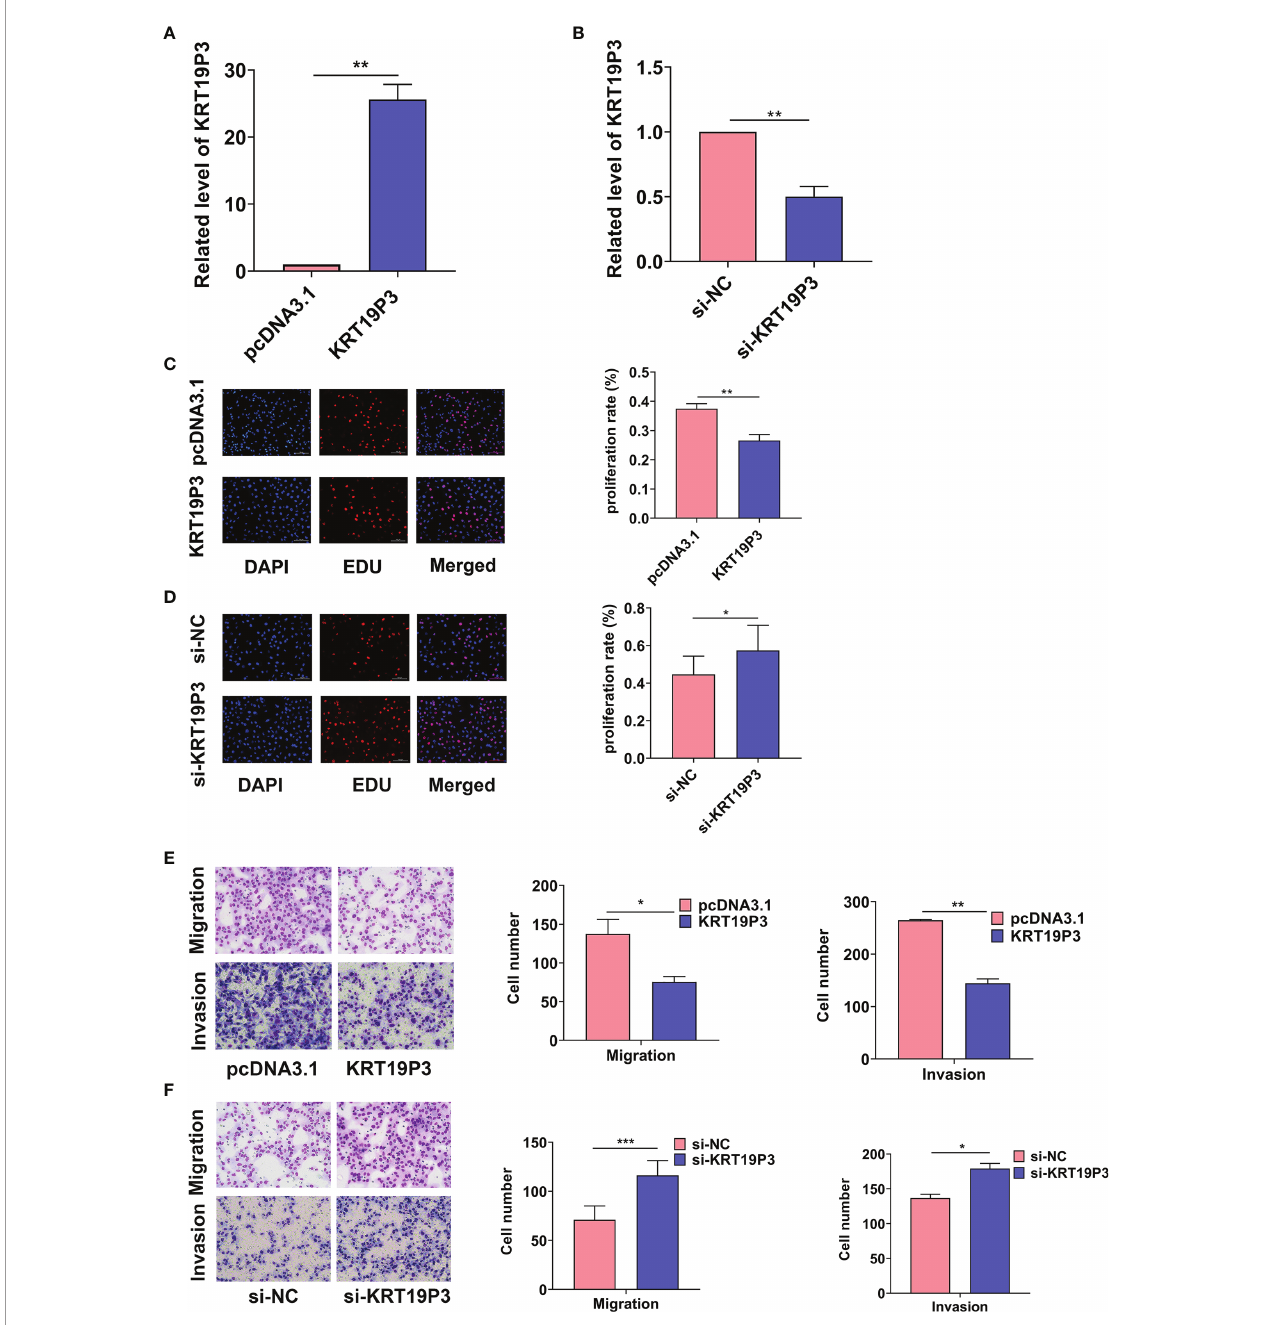
FIGURE 1 | KRT19P3 inhibited BC cell proliferation, migration and invasion. (A) RT-qPCR results showed that pcDNA3.1-KRT19P3 transfection signi fi cantly increased the KRT19P3 level in MDA-MB-231 cells. (B) RT-qPCR results showed that siRNA transfection signi fi cantly decreased the KRT19P3 level in MDA-MB-231 cells. (C) EDU assay to detect the effect of overexpression of KRT19P3 on cell proliferation. (D) EDU assay to detect the effect of interfering KRT19P3 on cell proliferation. (E) Transwell assay to detect the effect of overexpression of KRT19P3 on cell migration and invasion. (F) Transwell assay to detect the effect of interfering with KRT19P3 on cell migration and invasion. * P < 0.05, ** P < 0.01, *** P <